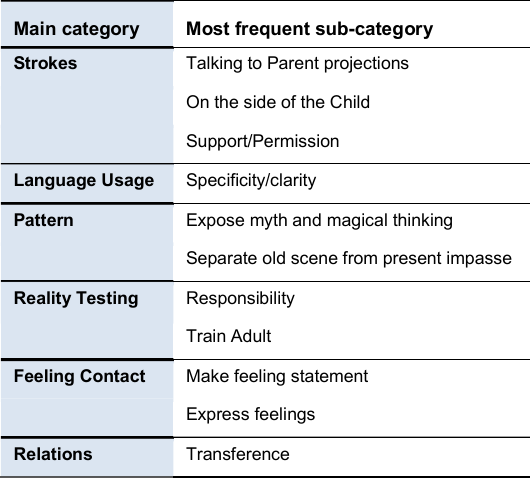
Table 5 :The most frequent sub-categories under each main